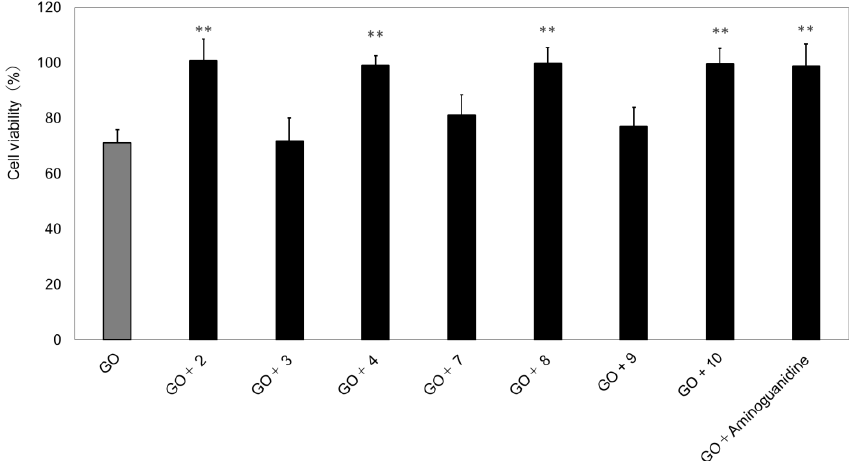
Figure 8. Glycation suppression with selected purified compounds in the presence of glyoxal (GO) in TIG-110 cells. n = 3. GO: Glyoxal (1.25 mM); aminoguanidine: Positive control (1.5 mM;, compounds 2 : chlorogenic acid, 3 : querucetin 3- O -glucopyranoside, 4 : (2 E , 6 R )-2, 6-dimethyl-2,7-octadien-6-ol-1- O - β - D -glucopyranoside, 7 : syringin, 8 : 5,5 ’ -diallyl-2,2 ’ -diglucopyranosyl-3,3 ′ -dimethoxy diphenyl ether, 9 : querucetin 4 ′ - O -glucopyranoside, 10 : kaempferol 4 ′ -O-glucopyranoside); sample concentration: 25 µg/mL (0.4% DMSO. The bars represent the mean + SD; ** p < 0.01 versus GO; student t -test.